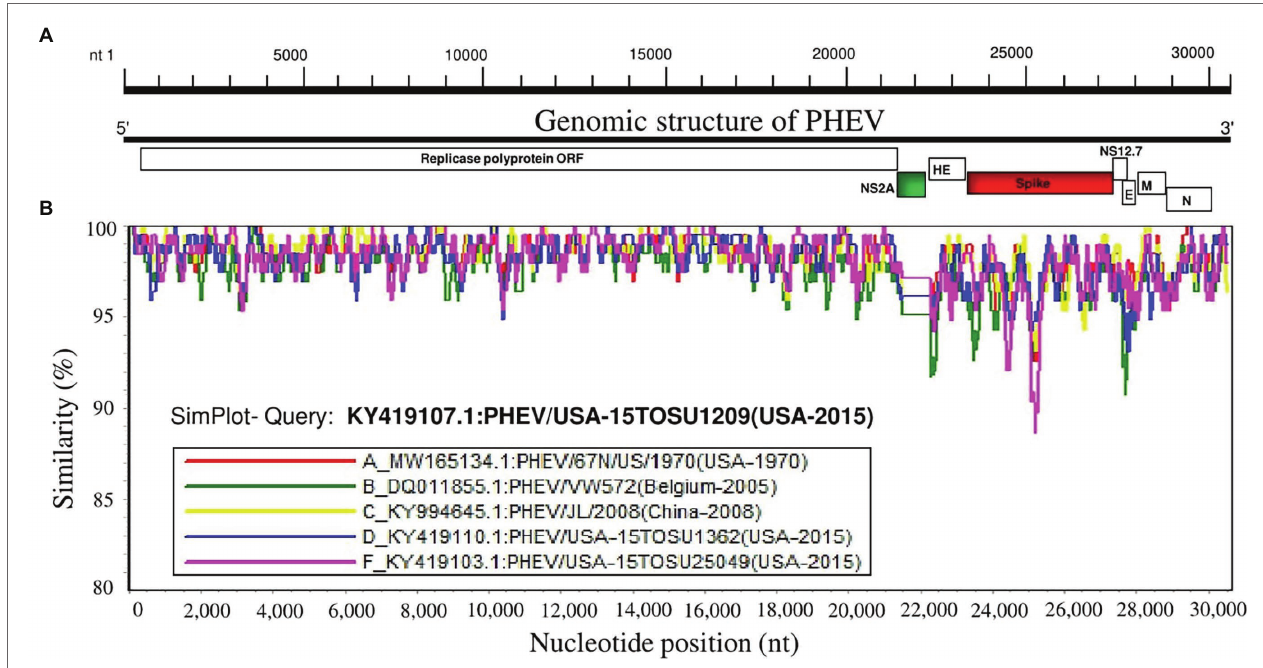
FIGURE 2 | Similarity map of the full-length genome sequence of representative PHEV isolates. (A) Schematic diagram of the complete PHEV genomic structure. From the 5 ′ end to the 3 ′ end are Replicase polyprotein ORF, accessory protein NS2A ORF, HE protein ORF, spike glycoprotein ORF, accessory protein NS12.7 ORF, envelope protein ORF (E), membrane protein ORF (M) and nucleocapsid protein ORF (N). (B) SimPlot similarity analysis results using SimPlot ver.3.5.1 (Lole et al.,